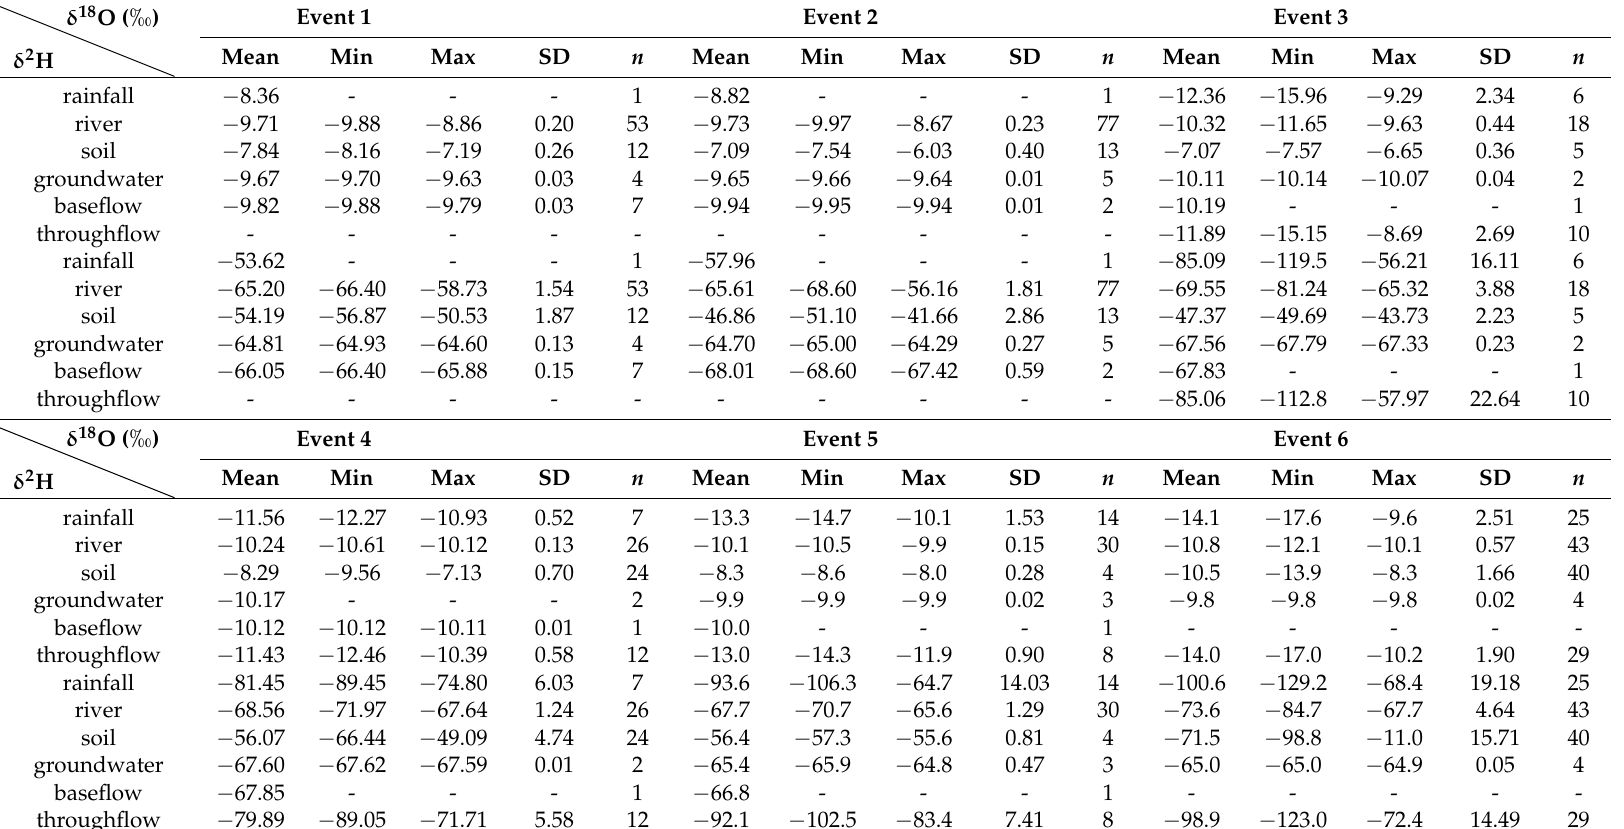
Table 2. Maximum (Max), minimum (Min), mean ± standard deviation (Mean ± SD) values of isotopic compositions ( δ 18 O and δ 2 H, water, base flow, soil water and groundwater corresponding to 6 storm events. Here n refers to total number of samples, soil water isotope ratios at all depths were included. Base flow is defined as all samples collected 2 h prior to the start of rainfall